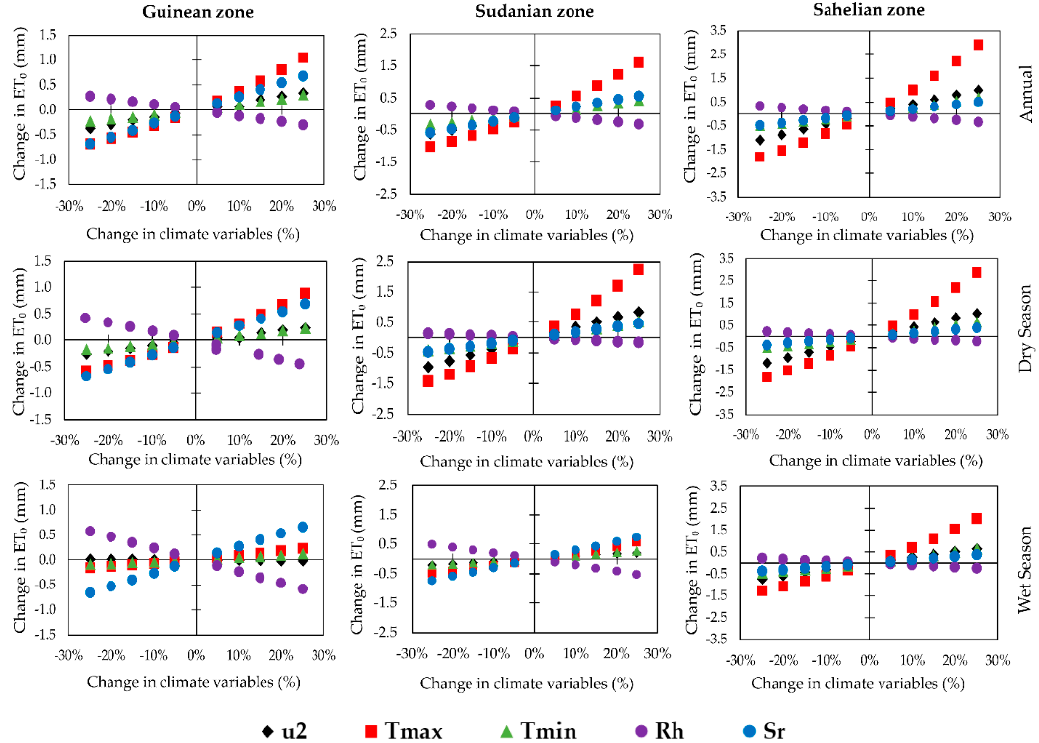
Figure 9. Sensitivity of evapotranspiration to climatic variables. (u2 wind speed, Tmax maximum temperature, Tmin minimum temperature, Rh relative humidity, Sr Solar radiation).